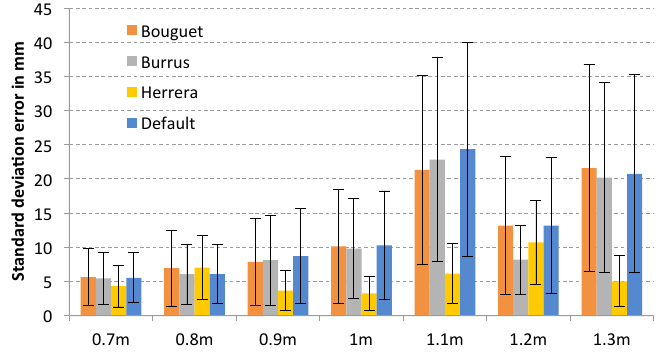
Figure 11. Plane fitting test error of each calibration method for Microsoft